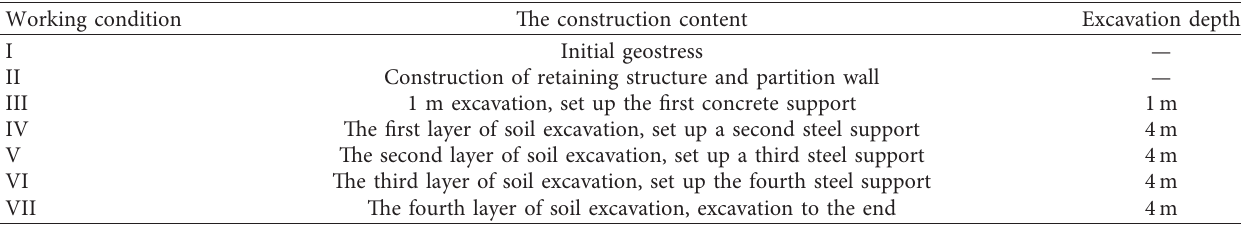
Table 2: Main excavated conditions of the foundation pit.